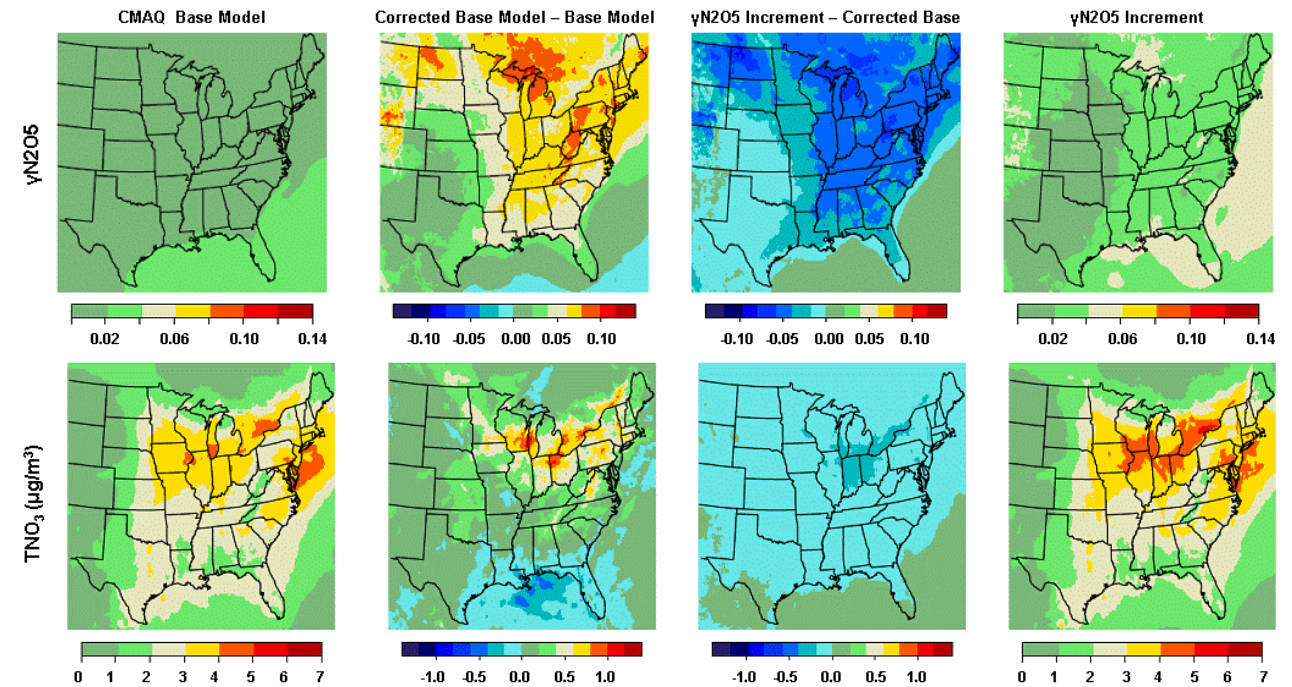
Fig. 1. Top row shows the average nighttime (04:00–09:00,GMT) values of γ N at the surface layer over the eastern United States during 2 O 5 January 2006. (Daytime hours are not included because N 2 O 5 concentrations are negligible during the day). Bottom row shows the TNO 3 concentrations (µg/m 3 ) averaged across all hours in January 2006. The first and last columns show model output from the base model and the γ N 2 O 5 Increment. The middle columns show the impact of correcting the error in the base CMAQ aerosol module and of using the new parameterization for the heterogeneous reaction